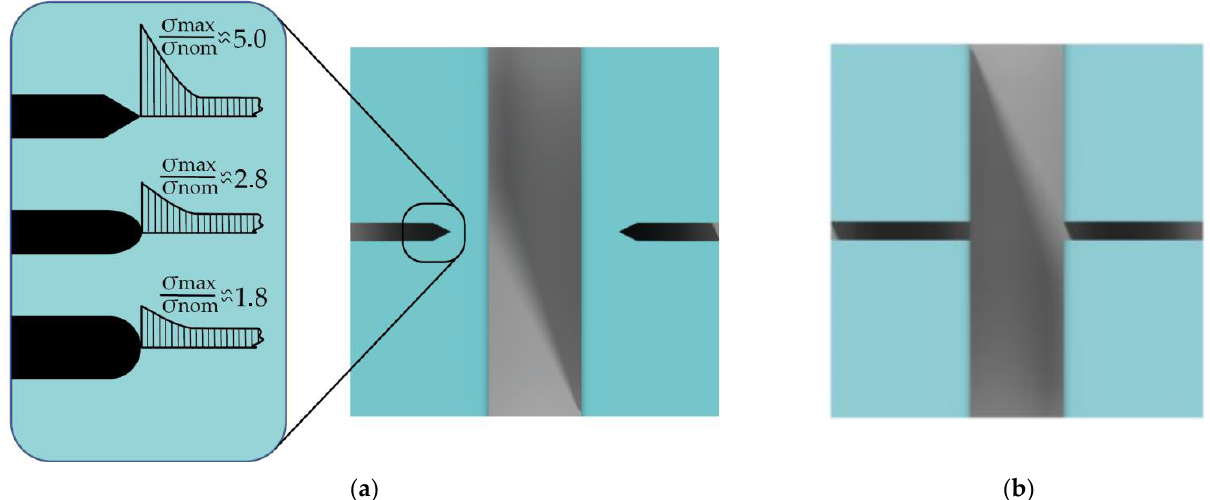
Figure 6. Two methods of forming auxiliary cleaving lines: ( a ) Etched dashed auxiliary line with the stress concentrators; ( b ) Transverse etched auxiliary crossing line.